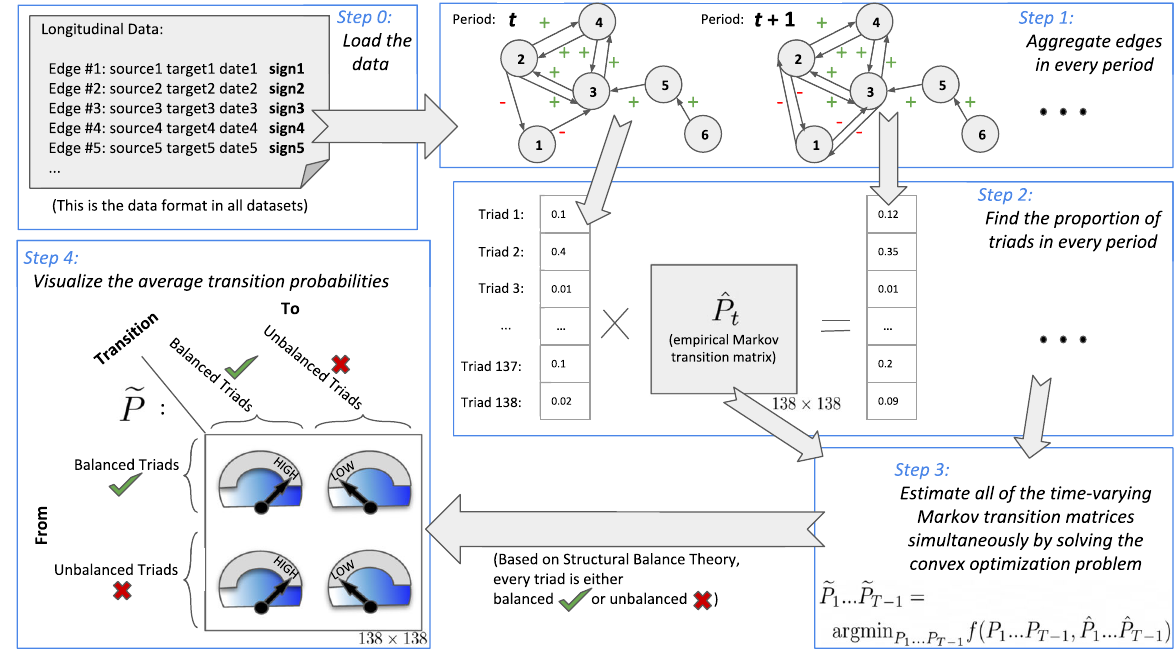
Fig. 4 Pipeline description. Estimation of transition probability matrices between balanced and unbalanced triads over a sequence of time periods. This fi gure illustrates the preprocessing steps, the optimization problem, and the results. Step 1: for all time periods t from 1 to T − 1 (where T is the maximum number of periods in that dataset), each edge is labeled using aggregated majority in that period as positive ( + ) or negative ( − ). Step 2: we compute the proportion of triads in every period and estimate the transition matrix at time t as the unknown matrix that multiplied by the vector of proportion of triads at period t gives the corresponding vector at period t + 1. Step 3: we estimate all transition matrices together using a time-varying Markov model. This step ensures that the results provide a holistic view of the available longitudinal data. Step 4: we visualize the probability of transition from balanced and unbalanced triads in time-varying estimated transition matrices. By allowing null ties, there are 138 types of triads. P t represents the unknown transition matrix at time t and ^ P t represents the empirically estimated transition matrix at time t , and e P t represents the time-varying estimated transition matrix at time t . The four quadrants of ^ P t show the average estimated transition probabilities (see “ Methods ” for details). The result of this experiment is shown in Fig.